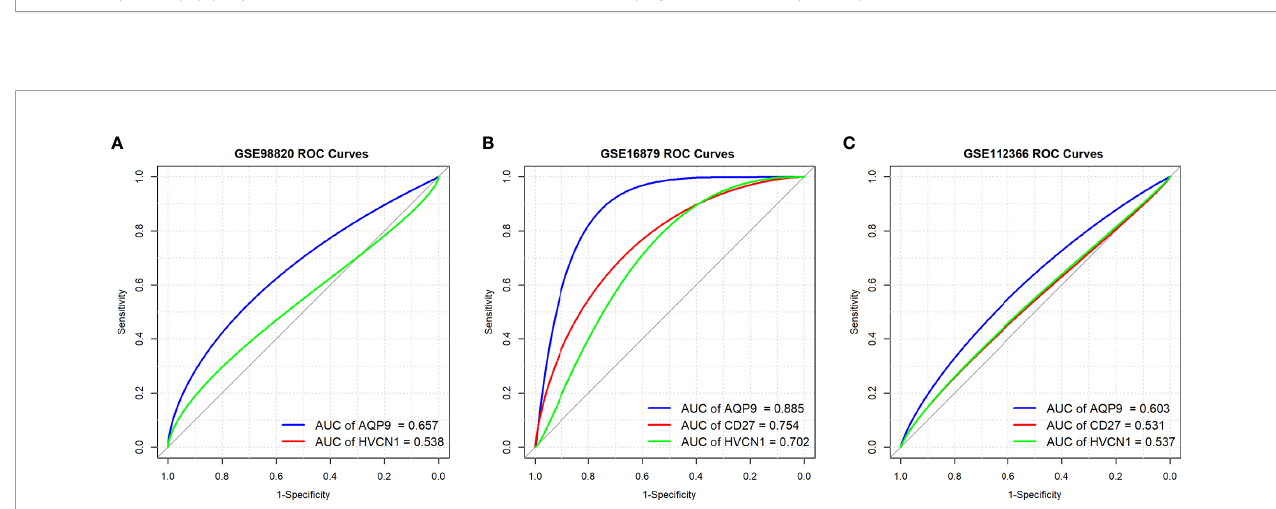
FIGURE 5 | Predictive values of AQP9 , CD27 and HVCN1 in the treatment of CD. (A) Predictive value of AQP9 and HVCN1 in the treatment of CD (GSE98820); (B) Predictive value of AQP9 , CD27 and HVCN1 in the treatment of CD (GSE16879); (C) Predictive value of AQP9 , CD27 and HVCN1 in the treatment of CD